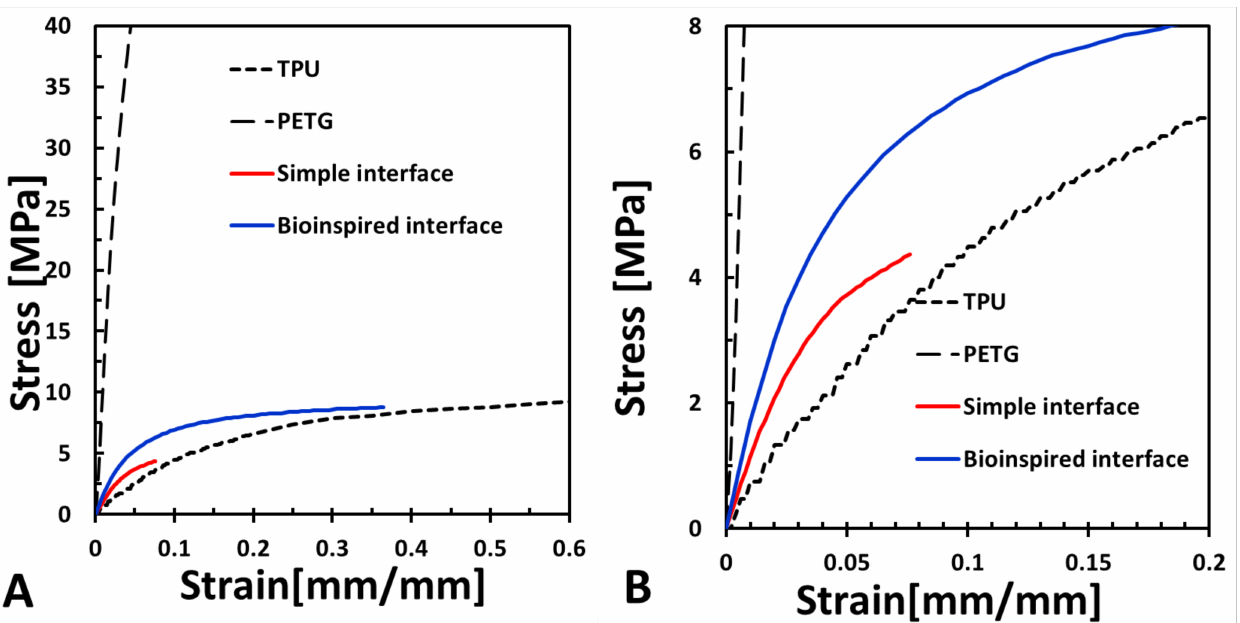
Figure 5. ( A , B ) Mechanical behavior for 3D-printed PETG, TPU, and combined samples with simple and bioinspired interfaces. ( B ) is the enlarged representation of ( A ).